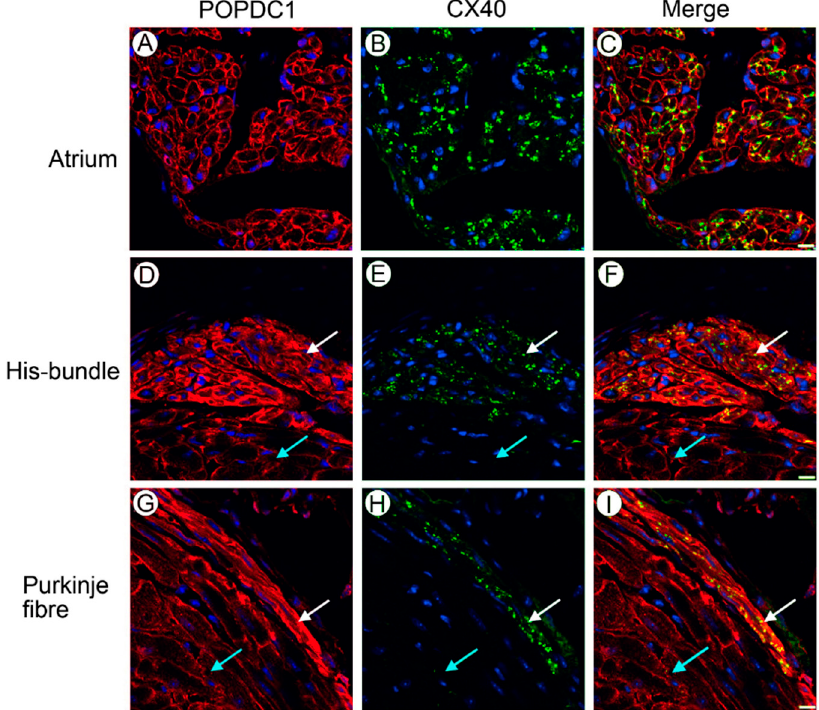
Figure 2. Differential expression of POPDC1 in the murine heart. POPDC1 is expressed at higher levels in the ( A – C ) atria, ( D – F ) His bundle and ( G – I ) Purkinje fibres in comparison to the ventricular working myocardium. Frozen sections of mouse myocardial tissue were immunohistochemically stained with antibodies directed against POPDC1 (red signal) and, as a marker of ventricular conduction tissue, Cx40 (green signal). The white arrows in ( D – I ) label ventricular conduction tissue, while the turquoise arrows label ventricular working myocardium.